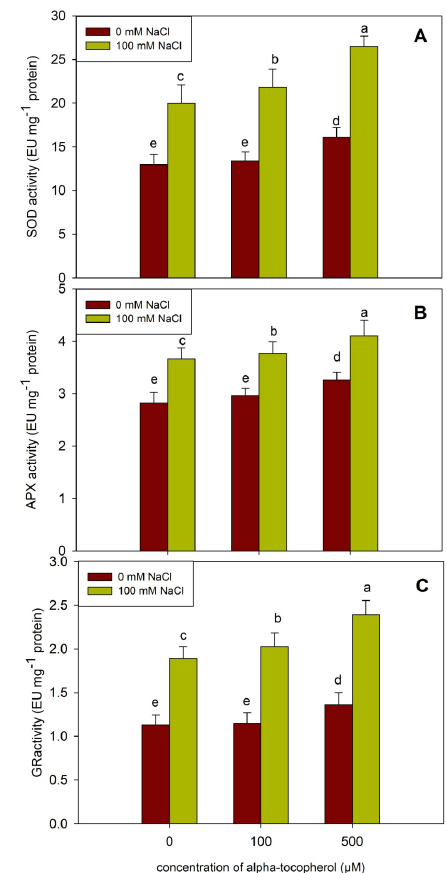
Fig. 4: Effect of increased salinity (100 mM NaCl) stress with and without exogenous application of α-tocopherol (100 and 500 μM) on (A) ascorbate, (B) reduced glutathione and (C) α -tocopherol content in soybean ( Glycine max ). Values are mean (±SE) of five replicates and different letters represent significant difference at P<0.05.